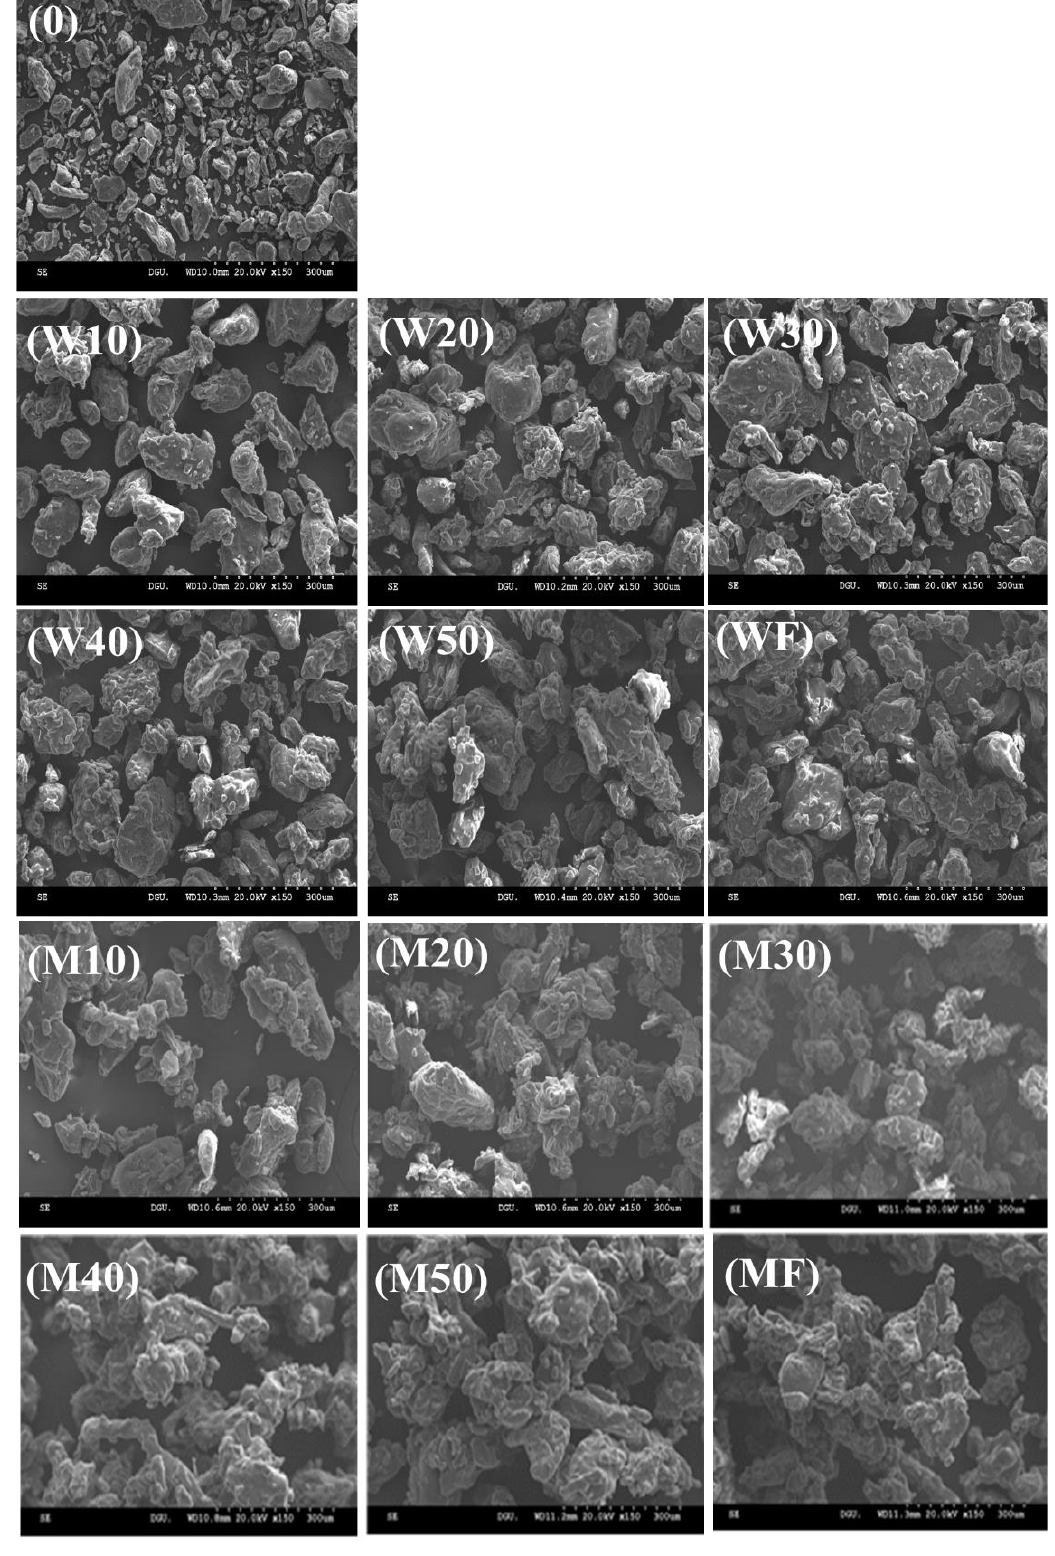
Figure 2. SEM images of native ( 0 ) and agglomerated XG powders with water ( W10 – W50 ) and MD ( M10 – M50 ) binders at different agglomeration times (10, 20, 30, 40, and 50 min): ( W10 , M10 ) 10 min, ( W20,M20 ) 20 min, ( W30 , M30 ) 30 min, ( W40 , M40 ) 40 min, ( W50 , M50 ) 50 min, and ( WF , MF ) final powder. Magnification 150×.